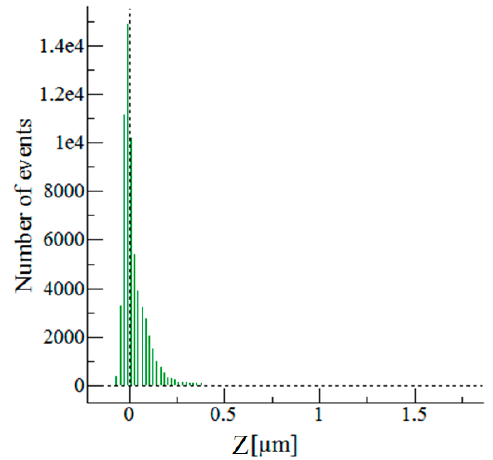
Figure 4. Height distribution of the 25 µm × 25 µm analyzed area. Table 1. Roughness parameters.